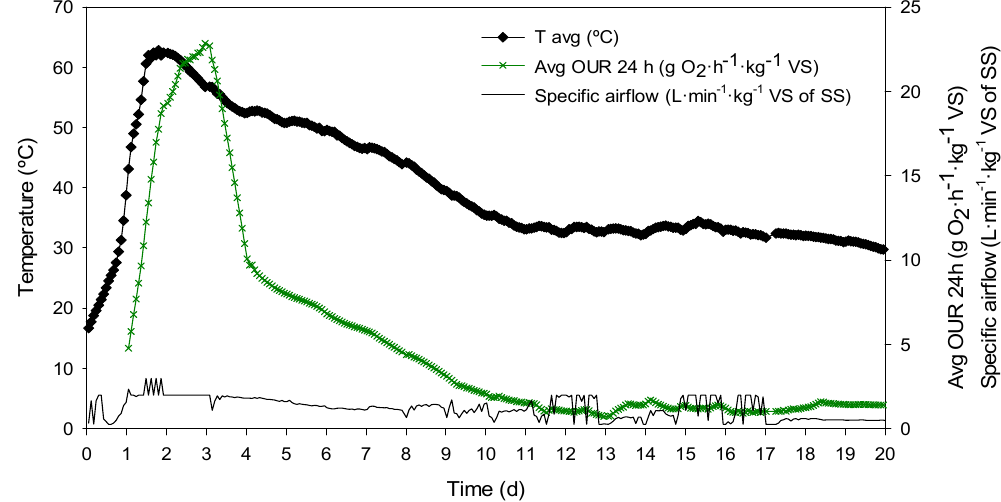
Figure 2. Performance of the composting process. Black dots represent the evolution of the average temperature of the reactor (°C); green crosses represent de average oxygen uptake rate (OUR) value for 24 h (g O 2 · h − 1 · kg − 1 VS); solid line represents the specific airflow passed through the reactor (L · min − 1 · kg − 1 VS of SS).